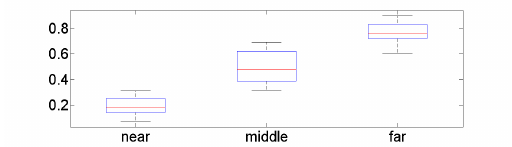
Figure 4: Results of the human study explained in Section 3.1. used to find values for α and β